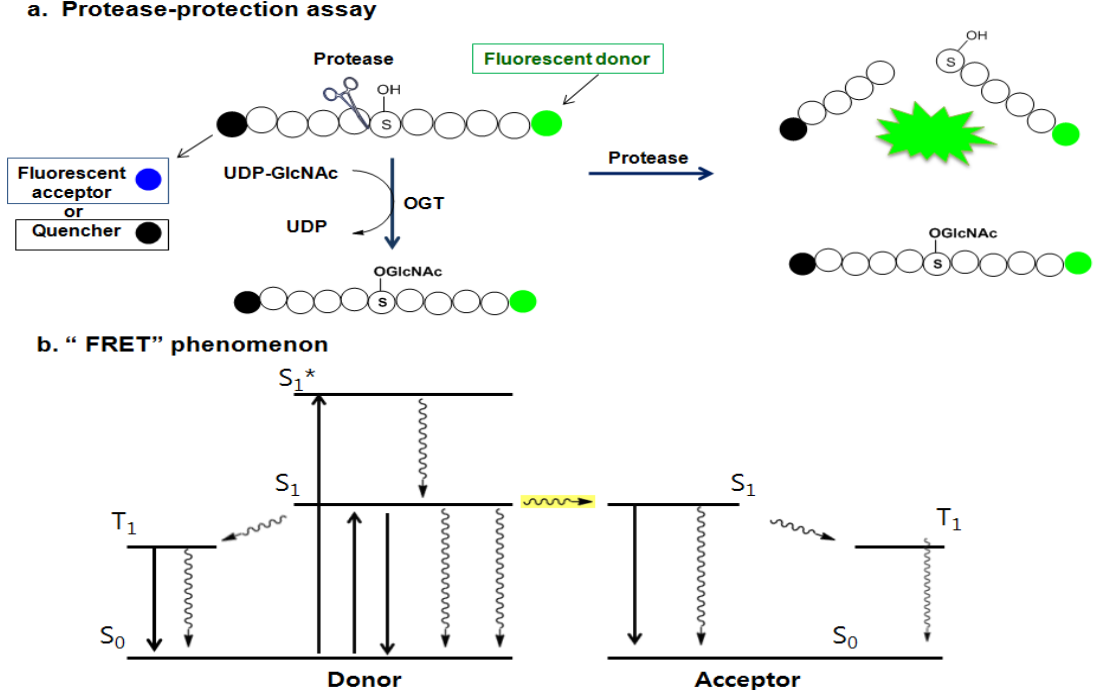
Figure 14. (a) Protease-protection assay: protease preferentially cleaves less sterically hindered unglycosylated peptide compared to the glycosylated peptide; and (b) the “FRET”